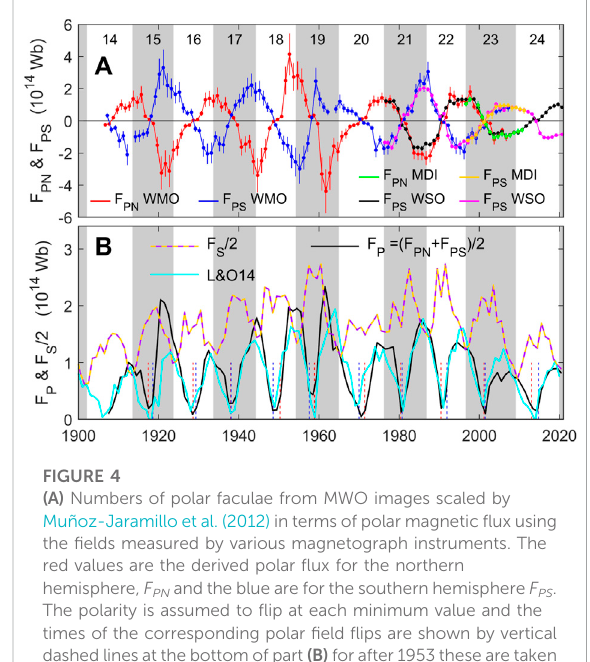
FIGURE 4 (A) Numbers of polar faculae from MWO images scaled by Muñoz-Jaramillo et al. (2012) in terms of polar magnetic fl ux using the fi elds measured by various magnetograph instruments. The red values are the derived polar fl ux for the northern hemisphere, F PN and theblue are for thesouthernhemisphere F PS . The polarity is assumed to fl ip at each minimum value and the times of the corresponding polar fi eld fl ips are shown by vertical dashedlinesatthebottomofpart (B) forafter 1953thesearetaken from magnetograms and before then from Kodaikanal observations (see text). The green and orange lines are the polar fl ux values derived from the Michelson Doppler Imager (MDI) magnetograph on the SoHO satellite for, respectively, the northern and southern hemisphere the and the black and mauve line are the corresponding values derived from the WSO magnetograph. (B) Comparison of the mean polar fl ux (| F PN | + | F PS |)/2 (black line) compared with F S /2 (orange and mauve dashed line),where F S isthesigned OSFandthefactor2isdiscussedinthe text. The cyan line is the coronal hole open fl ux, F CH from the continuity modelling of Lockwood and Owens (2014), (L&O14) updated to